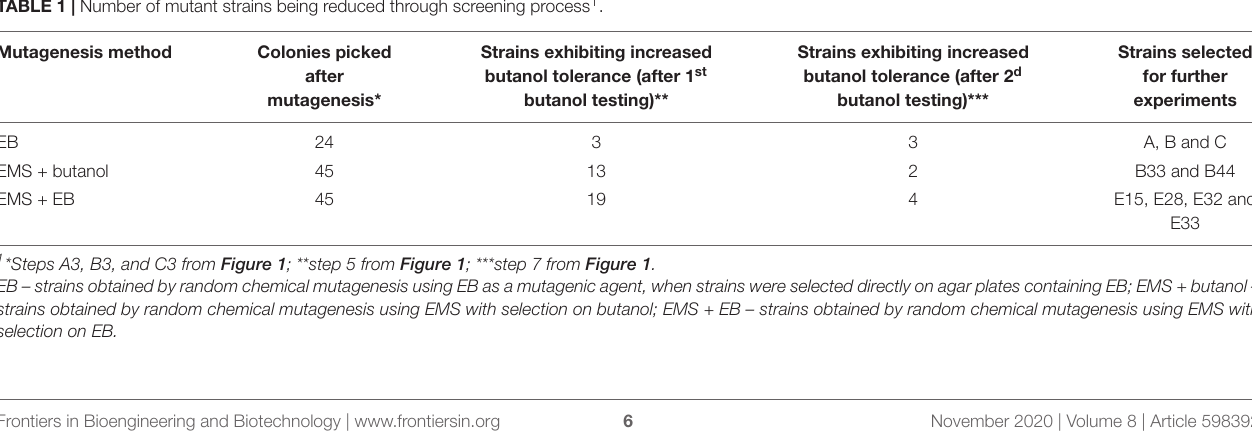
TABLE 1 | Number of mutant strains being reduced through screening process 1